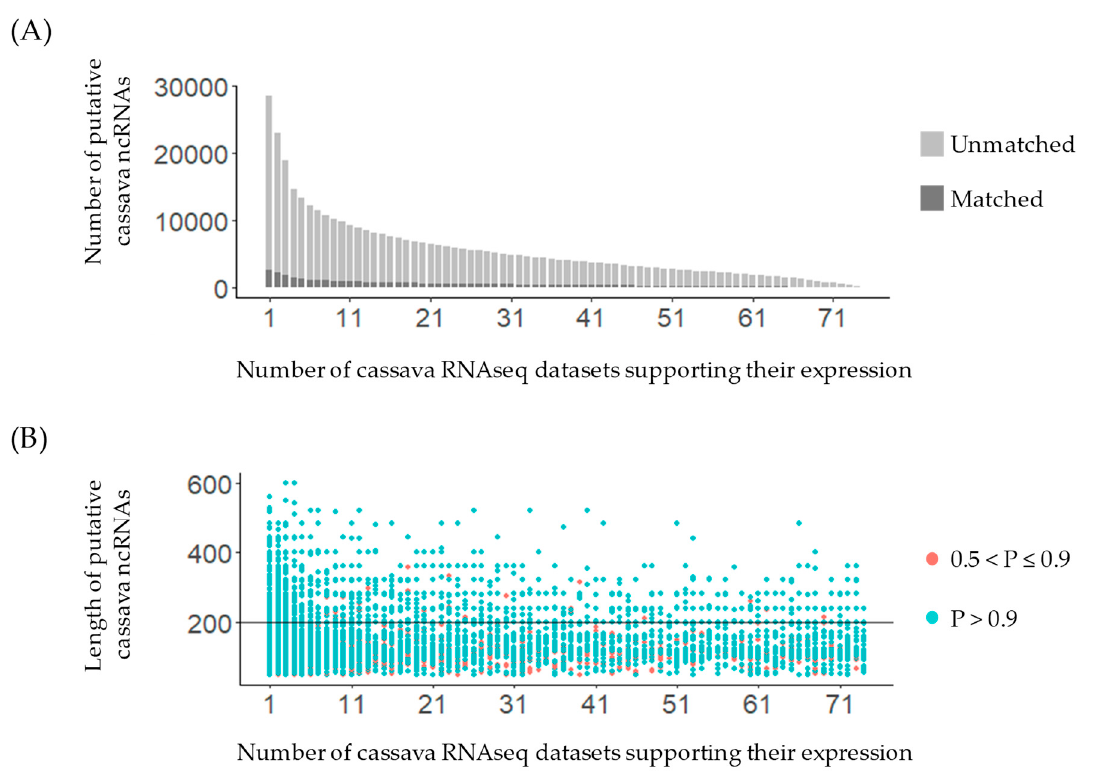
Figure 2. Consolidation of predicted ncRNA loci. ( A ) Inverse cumulative frequency graph of 56,840 putative ncRNA loci with number of RNA-seq datasets supporting their expression (Mapped reads ≥ 10 and coverage of breadth equal to 100%). ( B ) Characteristics of 51,832 putative ncRNA loci unmatched with previously published ncRNAs in terms of length, number of RNA-seq datasets supporting their expression, and the level of confidence based on RNAz-derived probability of being ncRNAs. The black line represents the cutoff for long and short putative ncRNAs.